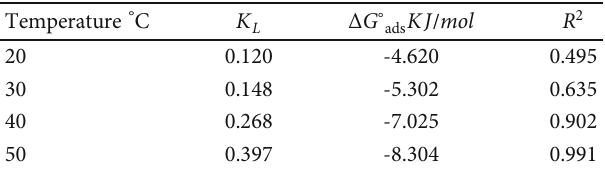
Table 5: Freundlich parameters for Freundlich adsorption isotherm of the PDL extract inhibitor for aluminium corrosion at di ff erent